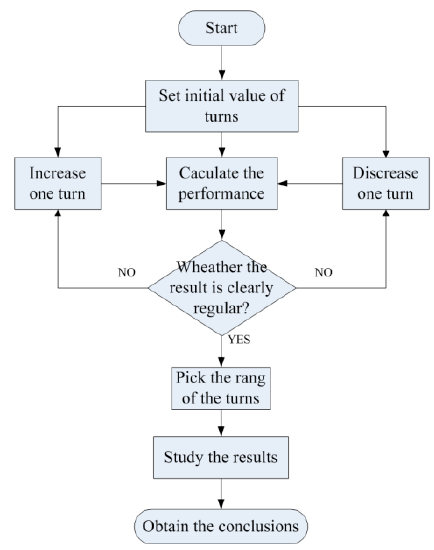
Figure 3. Program of the stator winding turns study.